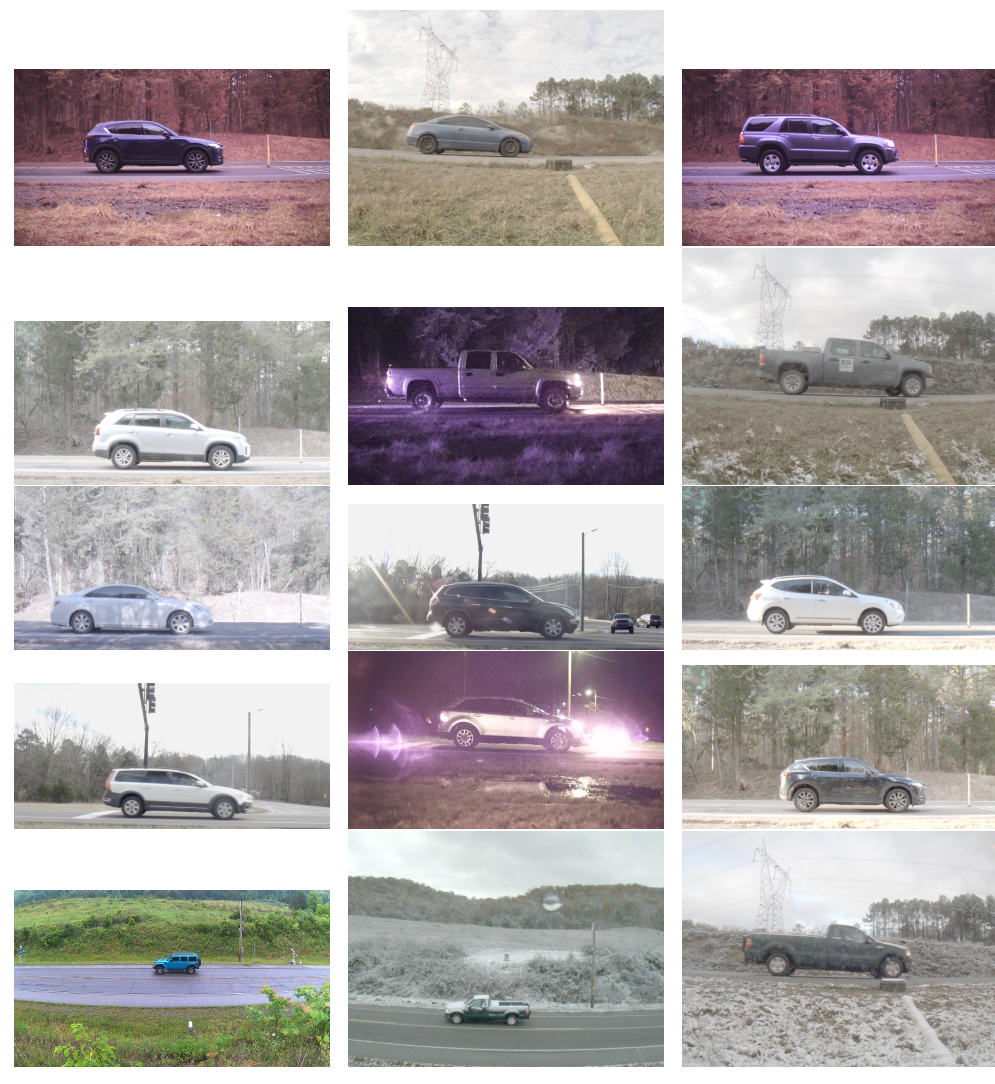
Figure 2. Sample images from the PRIMAVERA